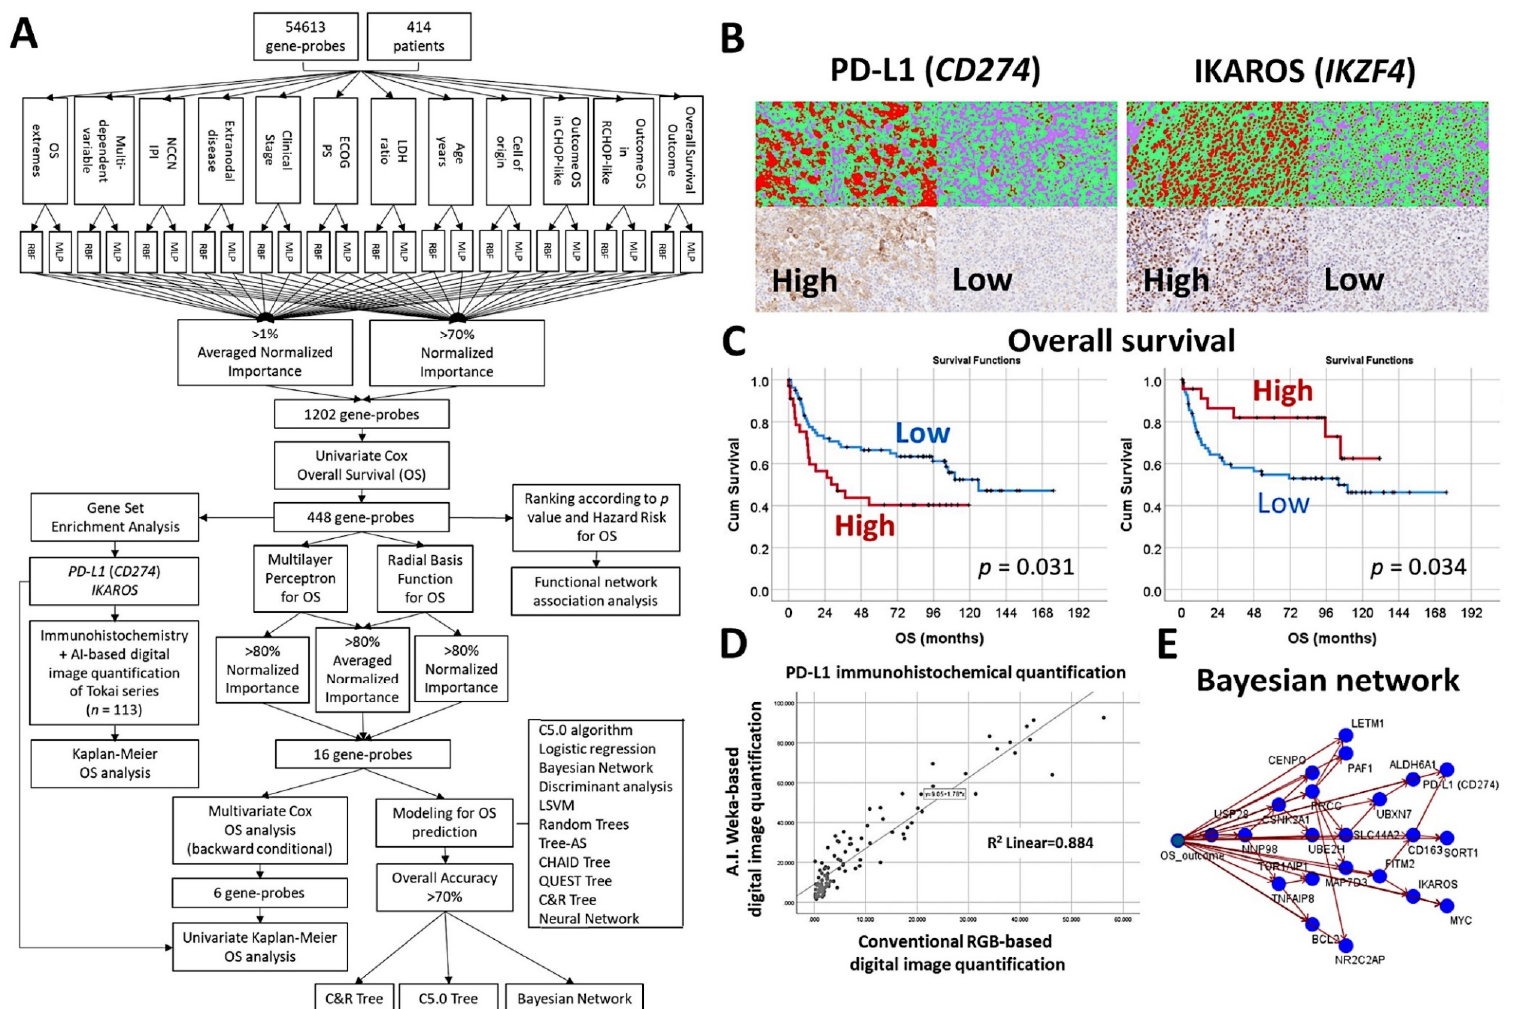
Figure 15. An algorithm that included artificial neural networks and machine learning predicted the survival of diffuse large B-cell lymphoma, and highlighted PD-L1 and IKAROS as prognostic markers. ( A ) Algorithm: This algorithm is similar to that one of follicular lymphoma and mantle cell lymphoma. The basic